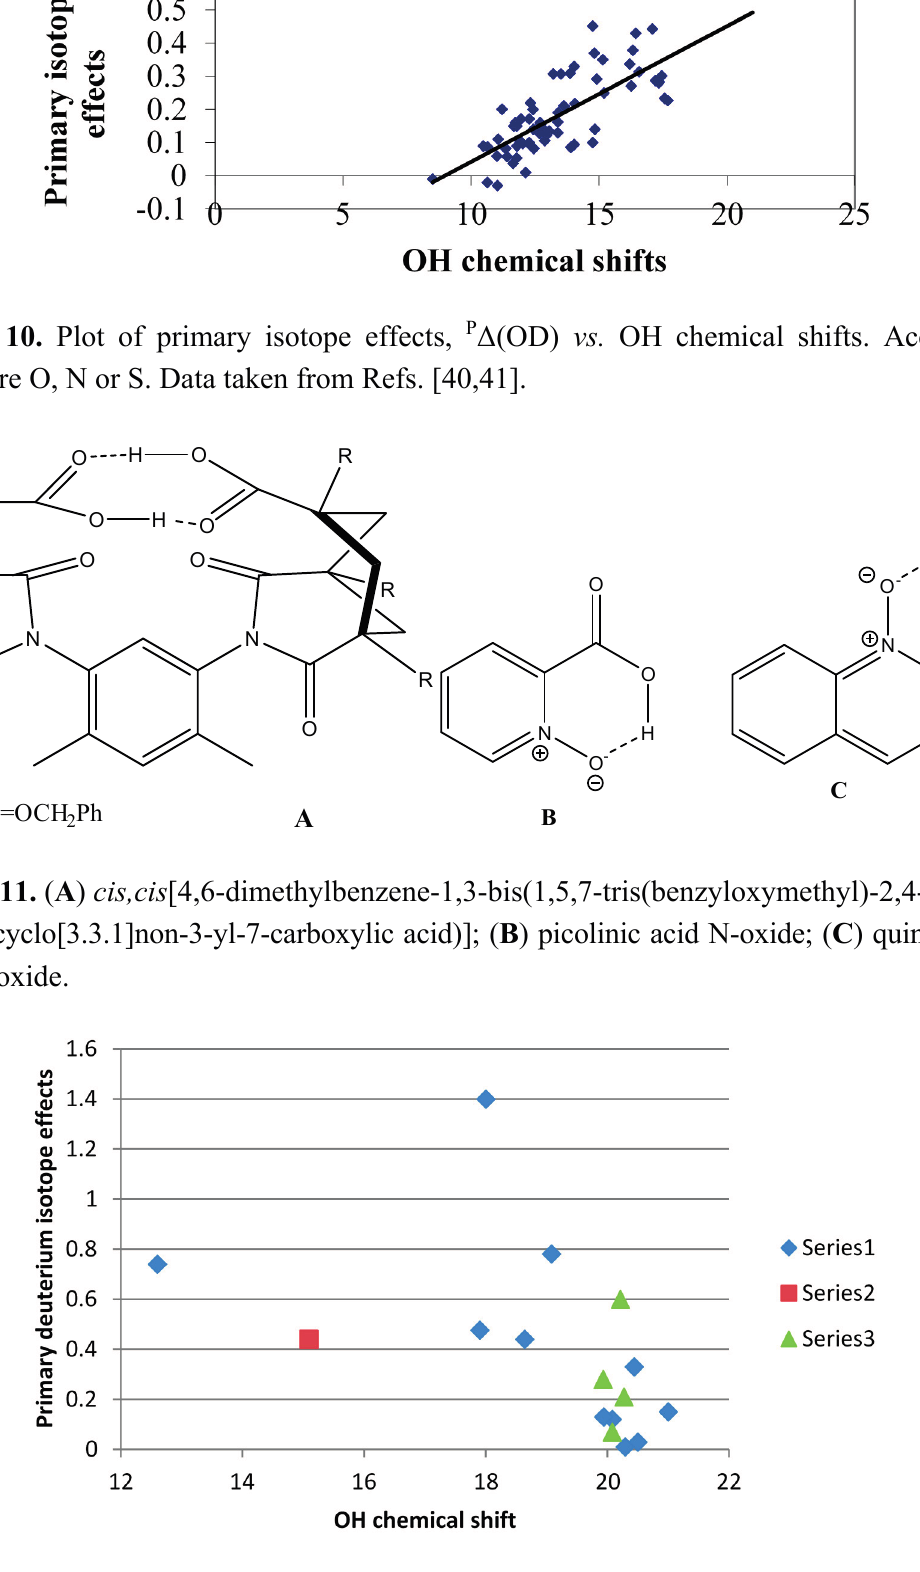
Figure 12. Plot of primary deuterium isotope effects for carboxylic acids vs. the OH chemical shift. Series 1 is; Data from Refs. [5,37,42,43] series 2 citrinin [44]; series 3 is data for mono anions of succinic acid